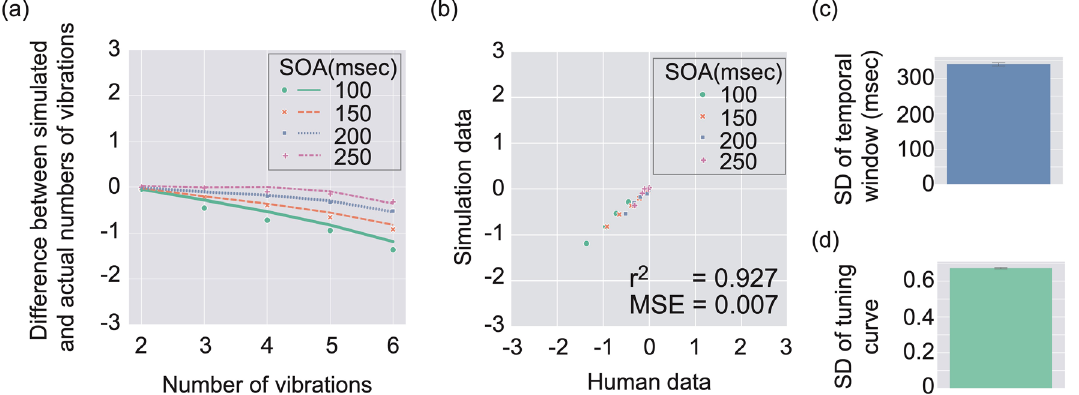
Figure 4. Simulation results. ( a ) Difference between simulated and actual numbers of vibrations is shown by using lines as a function of the number of vibrations in stimuli. Error bars indicate 95% confidence intervals (N = 20). Human data are replotted by using markers. ( b ) A correlation plot between human data (horizontal axis) and simulation data (vertical axis). ( c ) Mean SD of temporal window. Error bar denotes 95% confidence intervals ( N = 20). ( d ) Mean SD of tuning curves. Error bar denotes 95% confidence intervals ( N =